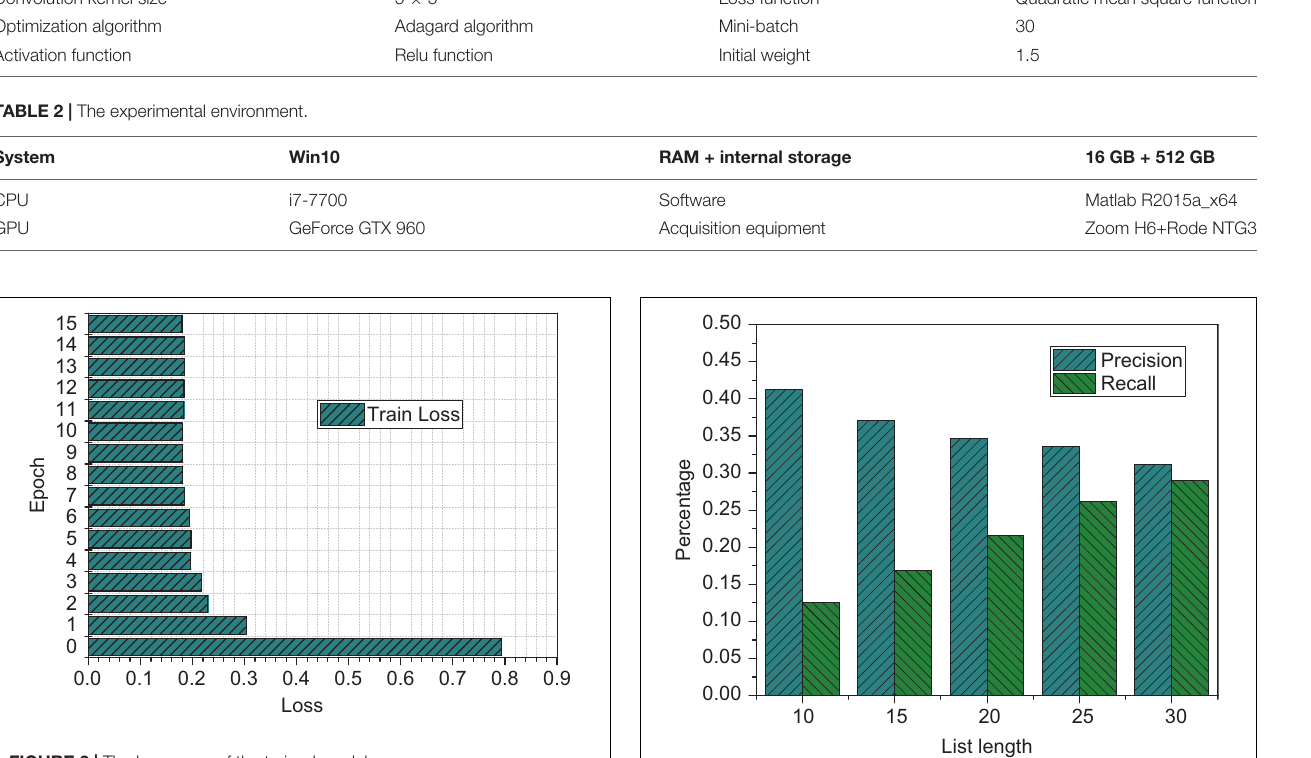
FIGURE 3 | The loss curve of the trained model.